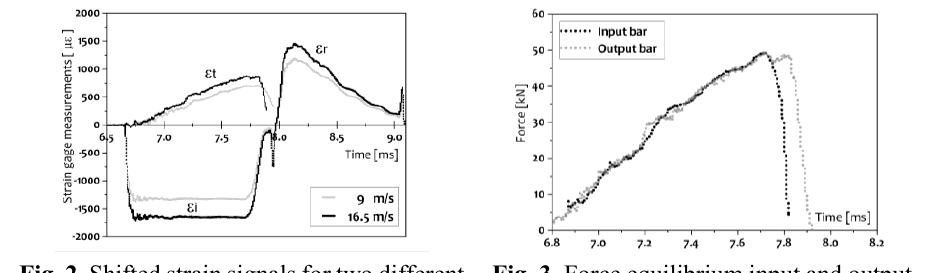
Fig. 2. Shifted strain signals for two different impactor velocities